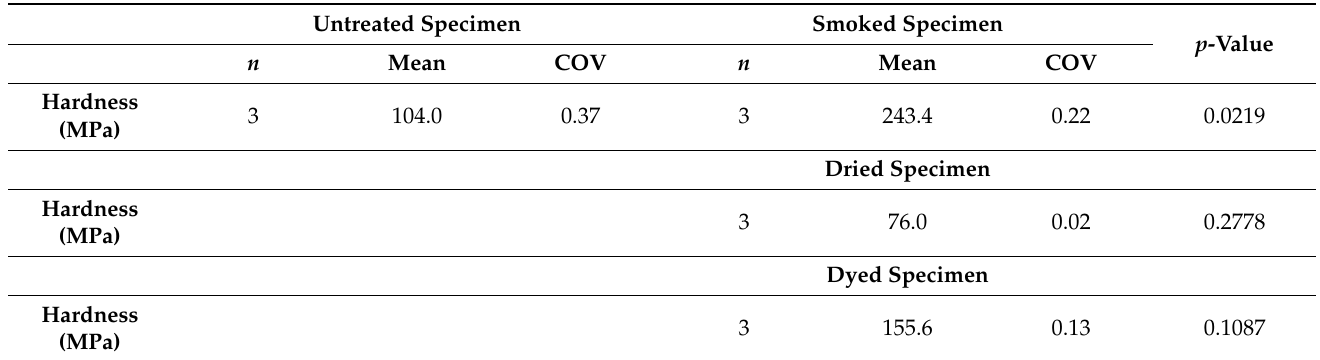
Table 4. Summary of p -values from unpaired t -test with a significance level of 0.05 to compare hardness test results between untreated and modified bamboo